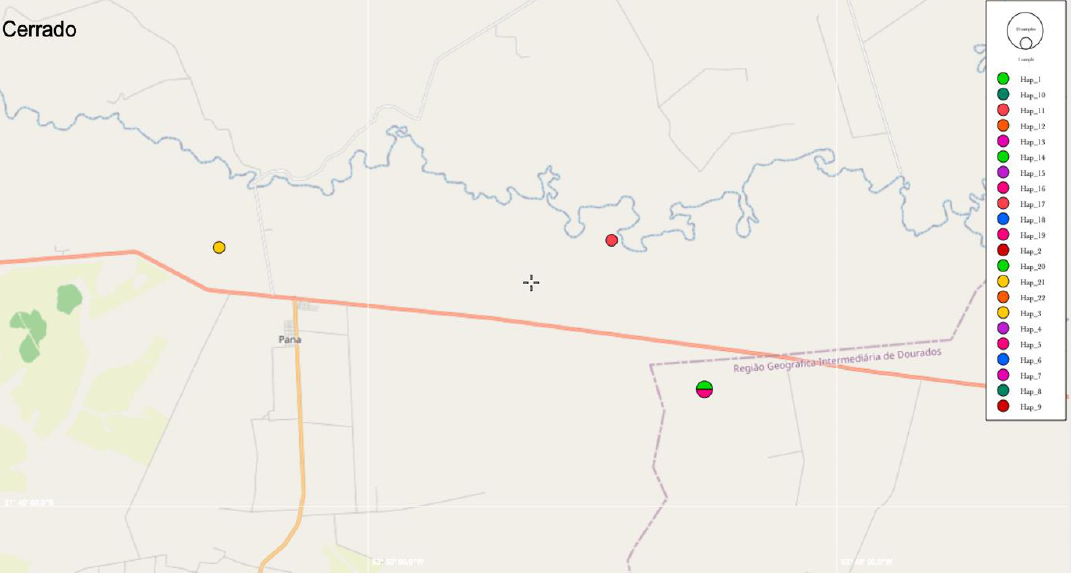
Figure 8. Representation of the genotype distribution of Cerrado biome areas. Map was constructed using PopART software based on GPS coordinates data of each sampling .